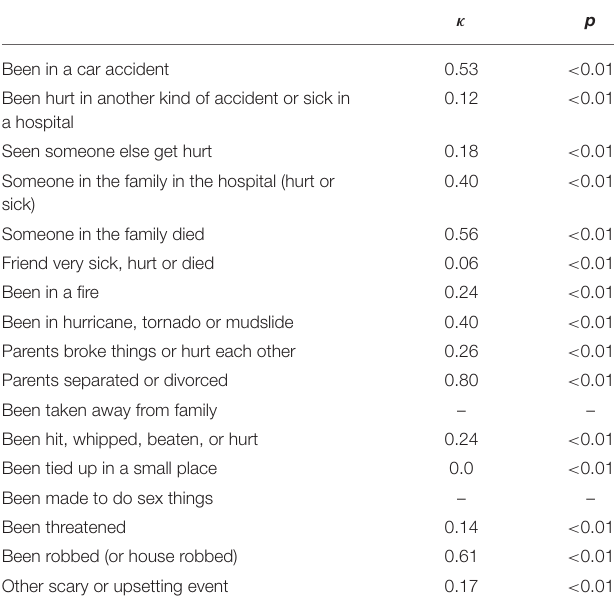
TABLE 6 | Correlations between the LITE-S and the LITE-P scales ( N = 280). r p ρ p All events 0.35 Lasting impact 0.31 < 0.01 0.33